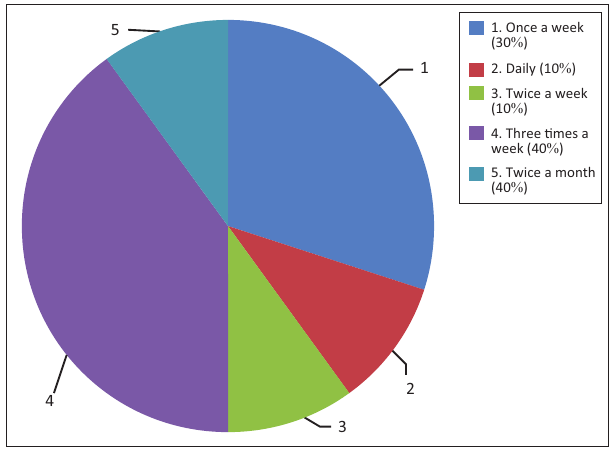
FIGURE 1: Frequency of reading to the